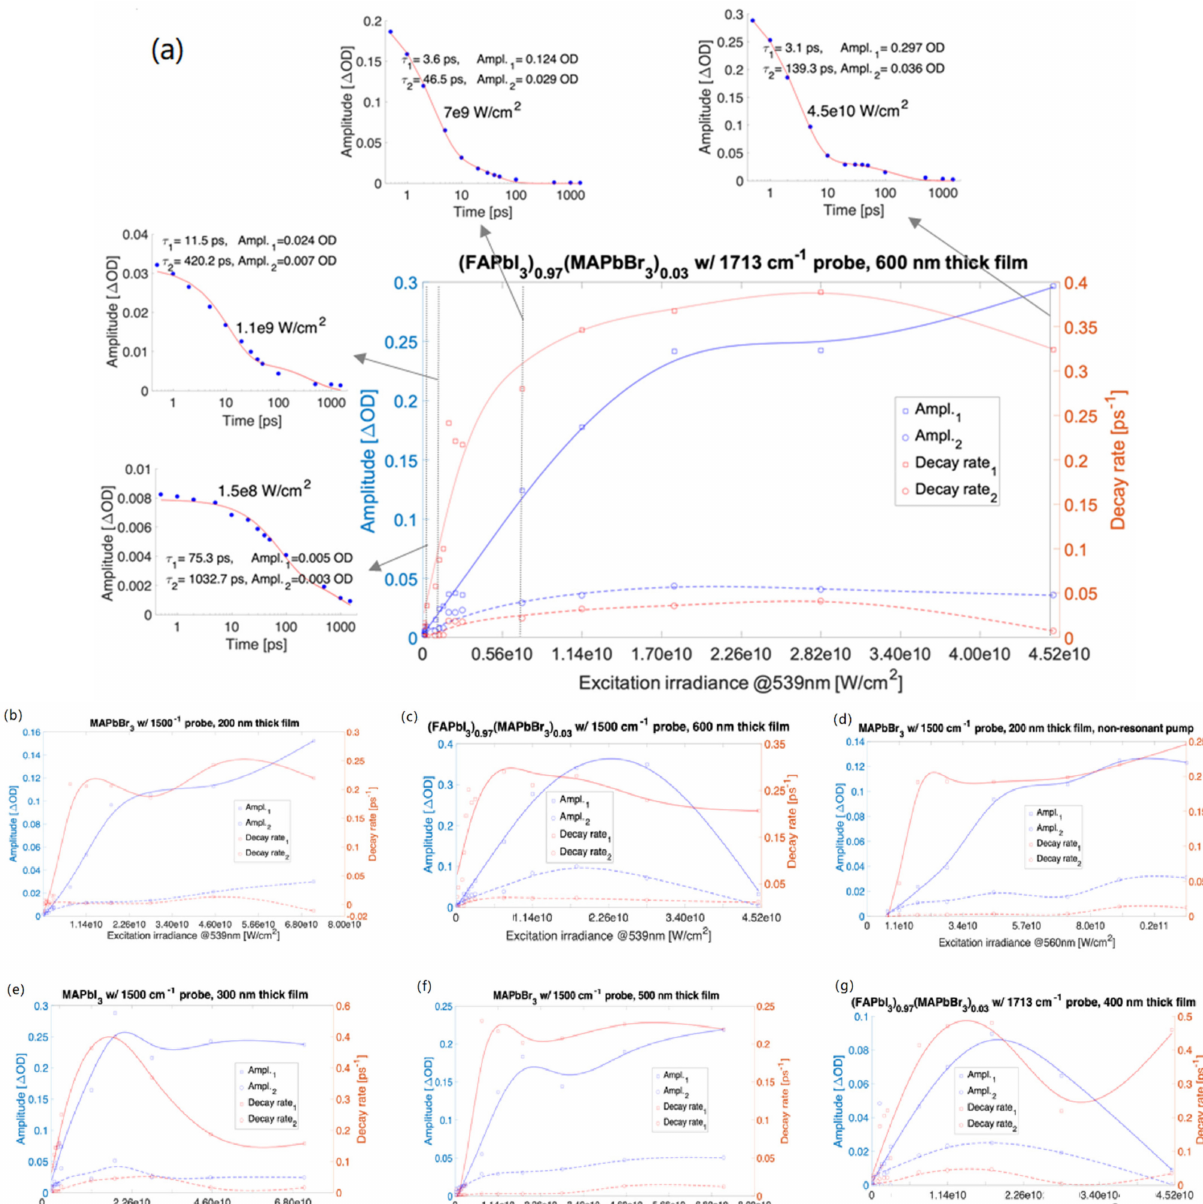
Figure 1. ∆ OD amplitudes and decay rates of bi-exponential fitting to difference absorption spec- tra with a resonant 539 nm pump (also at non-resonant 560 nm ( d )). (FAPbI 3 ) 0.97 (MAPbBr 3 ) 0.03 with 1713 cm − 1 probe—600 nm thick film, insets are kinetic traces taken at 1713 cm − 1 for selected irradiances ( a ), MAPbBr 3 with 1500 cm − 1 probe—200 nm film ( b ), MAPbBr 3 with 1500 cm − 1 probe—500 nm film ( c ), MAPbBr 3 with 1500 cm − 1 probe and with a non-resonant 560 nm pump—200 nm thick film ( d ), MAPbI 3 with 1500 cm − 1 probe—300 nm film ( e ), (FAPbI 3 ) 0.97 (MAPbBr 3 ) 0.03 with 1500 cm − 1 probe—600 nm film ( f ), and (FAPbI 3 ) 0.97 (MAPbBr 3 ) 0.03 with 1713 cm − 1 probe—400 nm film ( g ). The experimental data are depicted with square and circle symbols. The corresponding curves are the smoothing spline fits applied to amplitudes and decay rates fitted to the kinetic bi-exponentials. An extended version of Figure 1a is presented in the Supplementary Materials, Figure S77. e10 represents 1 × 10 10